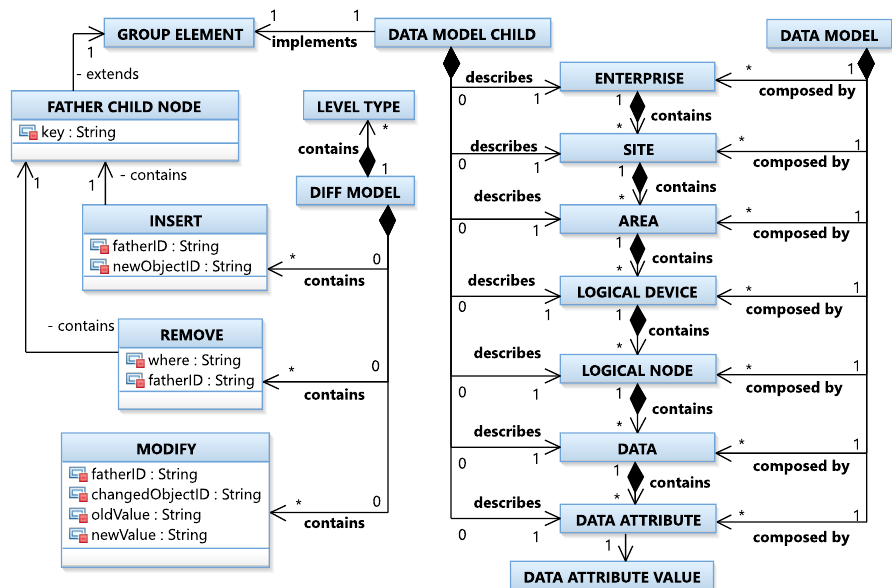
Figure 5. The Diff MetaModel structure for alerting users about ICPS evolution.